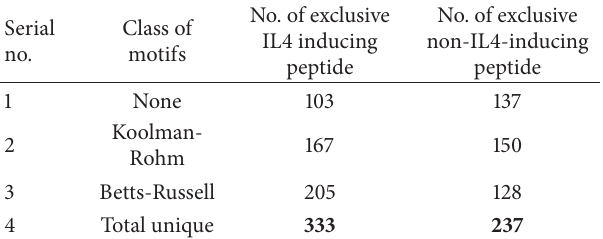
Table1:ExclusivemotifsofdifferentclassfoundinIL4inducingand non-inducing peptides. These motifs were discovered using MERCI